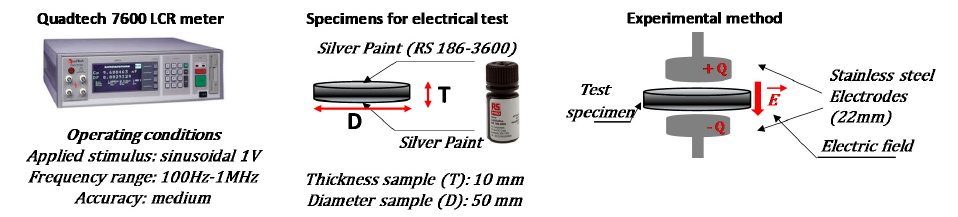
Figure 4. Schematic representation of electrical impedance spectroscopy measurements. From left to right: Quadtech 7600 LCR used for dielectric measurements ( left ) on circular specimens ( center ) with a capacitor method ( right ).